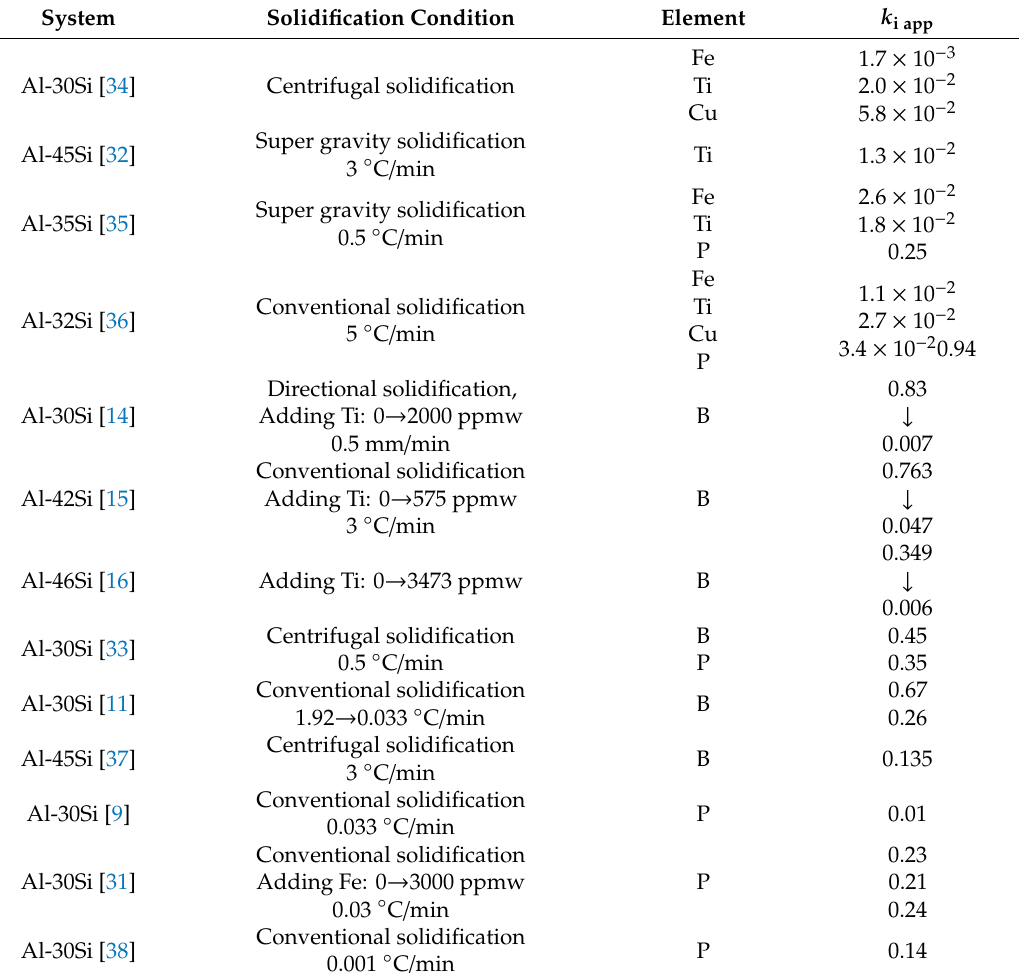
Table 2. Apparent segregation coe ffi cients of impurities obtained from the